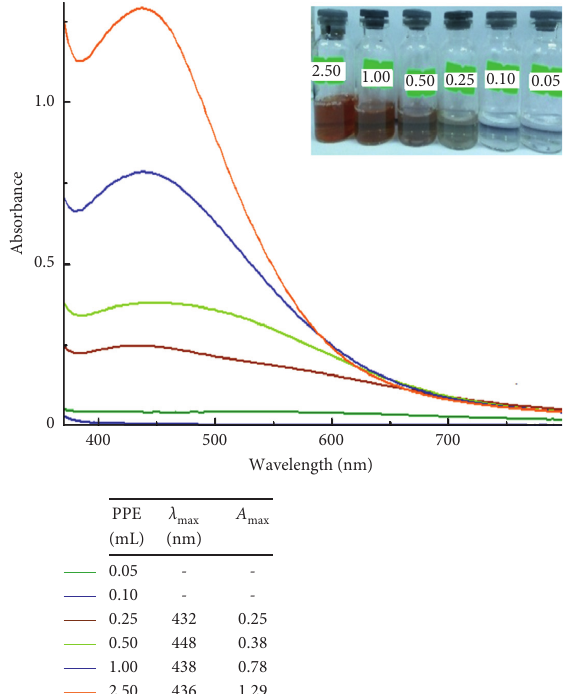
Figure 6: Higher amounts of PPE yielded more AgNPs. Inset table: maximum absorbance ( A